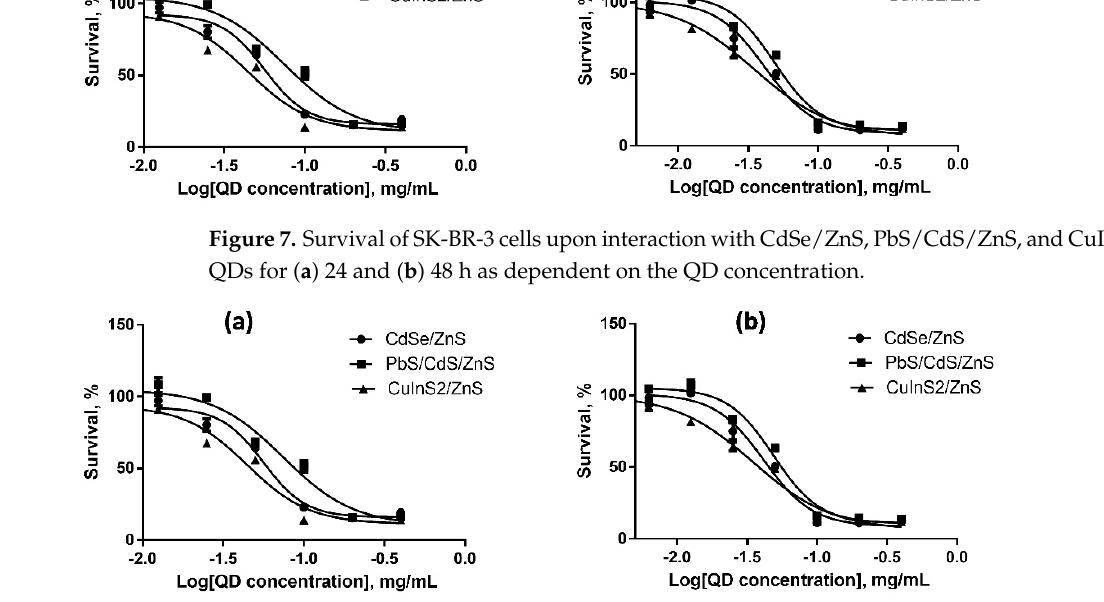
Figure 8. Survival of Wi-38 cells upon interaction with CdSe/ZnS, PbS/CdS/ZnS, and CuInS 2 /ZnS QDs for ( a ) 24 and ( b ) 48 h as dependent on the QD concentration. Table 3. Effects of the parameters of QDs of different types on their IC 50 for SK-BR-3 human breast cancer cells and WI-38 human fibroblasts.